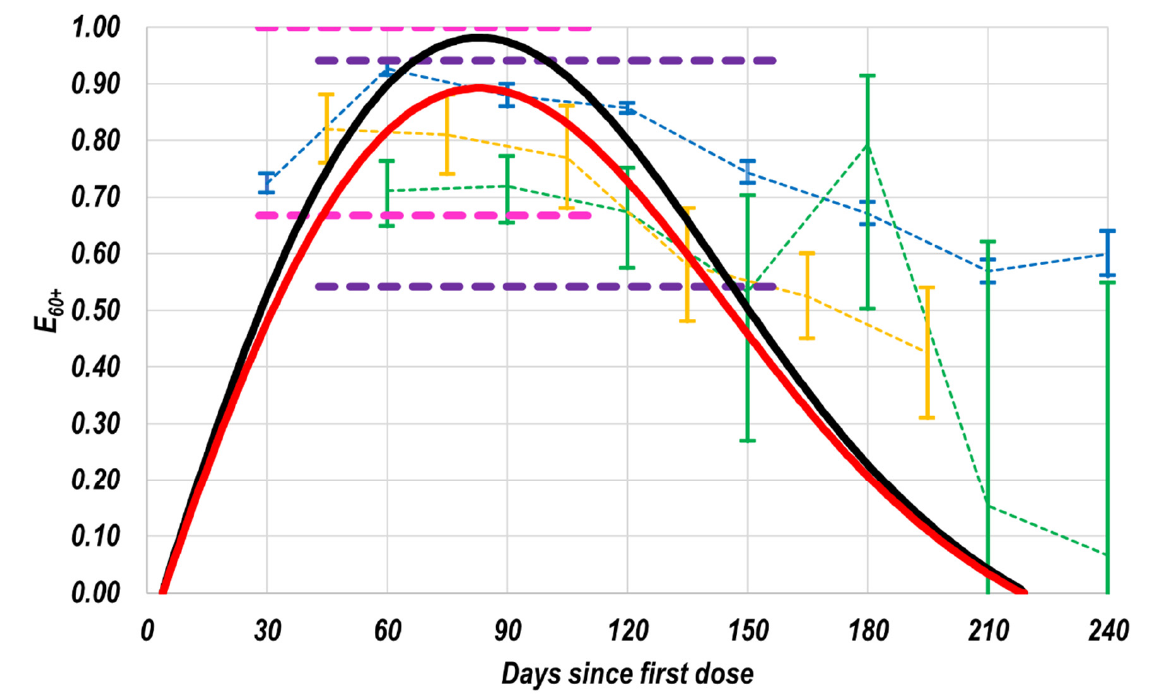
Figure 5. Comparison of the results of this study against previously reported information. Proposed E 60 + profiles (considering the f v (___) or the f (cid:48) (___) profiles). 95% CIs for the interest group published by the respective manufacturers for the BNT162b2 (- - -) [9] and AZD1222 (- - -) [10] vaccines. Set of E values as a function of the time from vaccination for the BNT162b2 vaccine (___) [16], (___) [17], and (___)